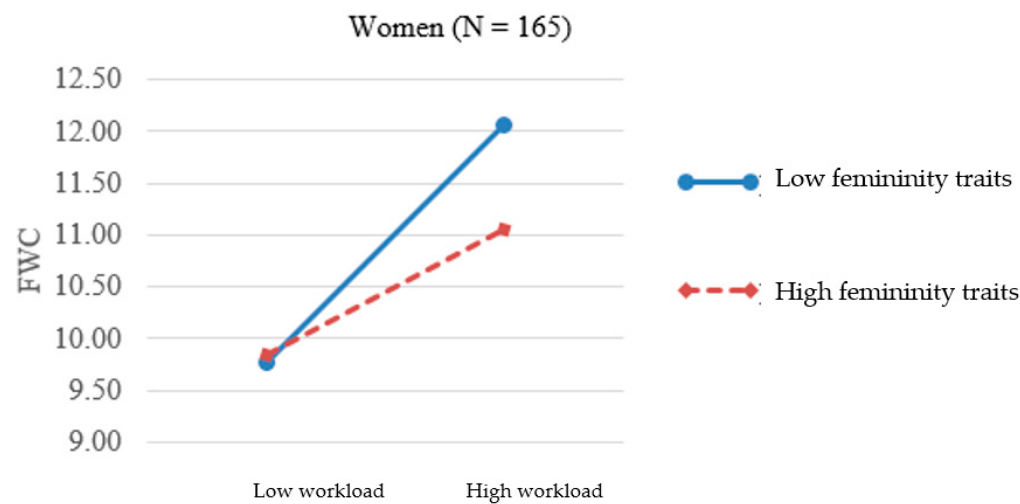
Figure 2. Interaction of femininity traits and workload on FWC for women.